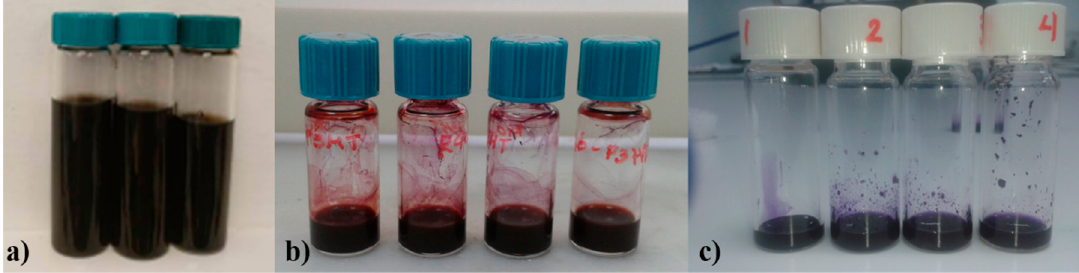
Figure 4. ( a ) Unmixed rGO ink, ( b ) P3HT:rGO, and ( c ) PCDTBT:rGO blends in controlled volume